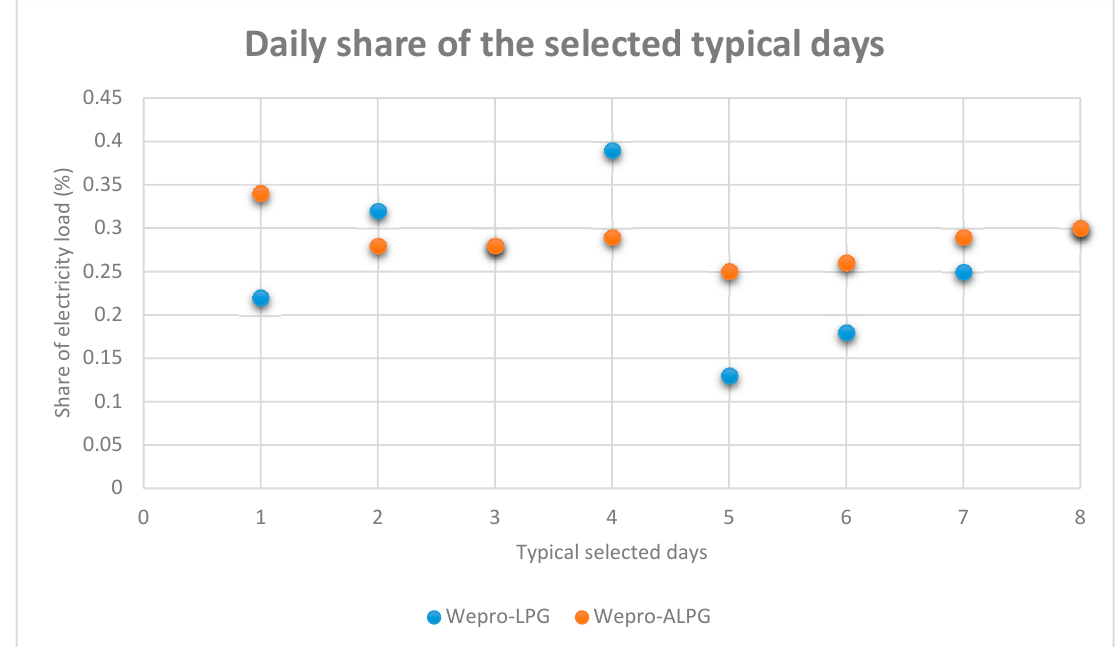
Figure 12. Daily share of electricity load of the selected typical days in each season based on the results of Wepro-LPG and Wepro-ALPG load profiles.